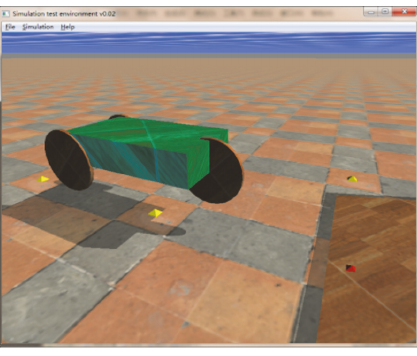
Figure 8: Vehicle